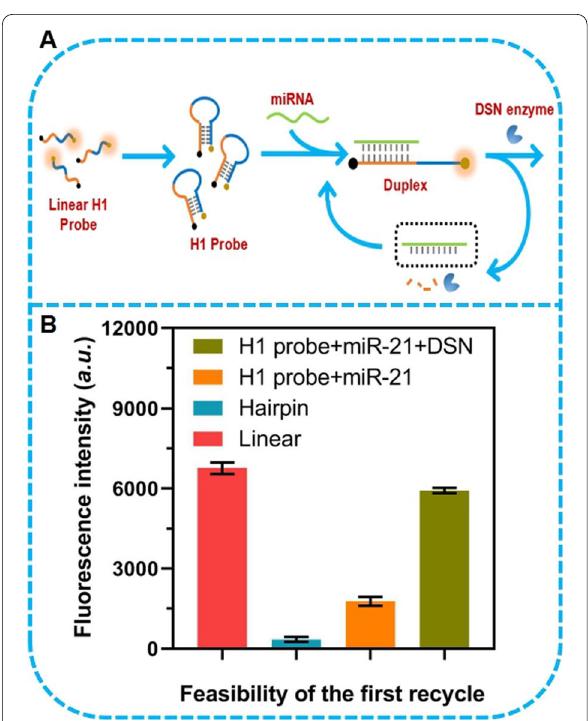
Fig. 3 Construction of the first signal recycle. A Illustration of the fluorescence assay to study the first signal recycle. B Fluorescence intensity of FAM labeled H1 probe on different experimental